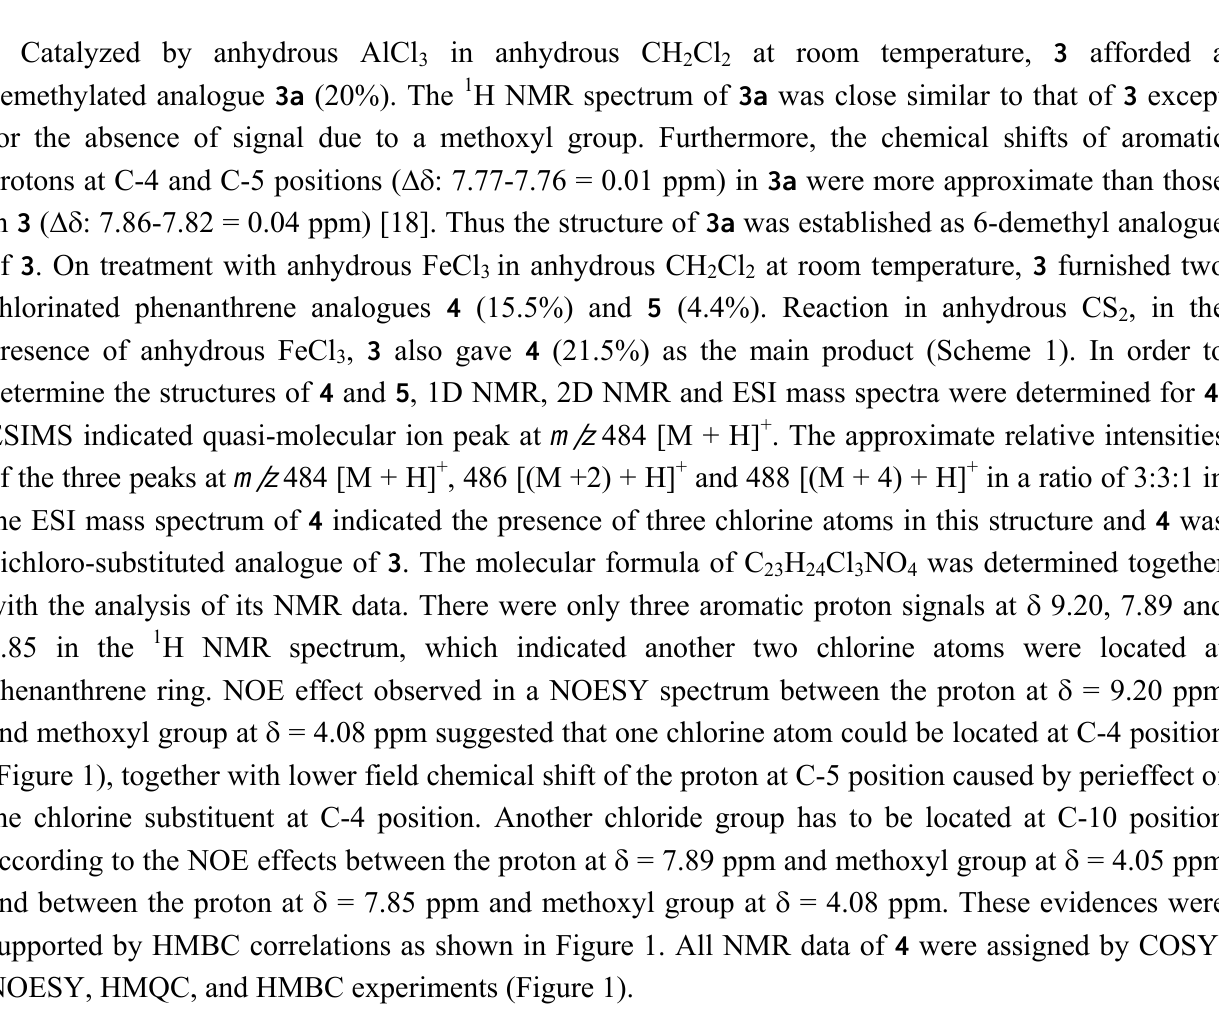
Figure 1. Relevant COSY, NOE and HMBC correlations of 4